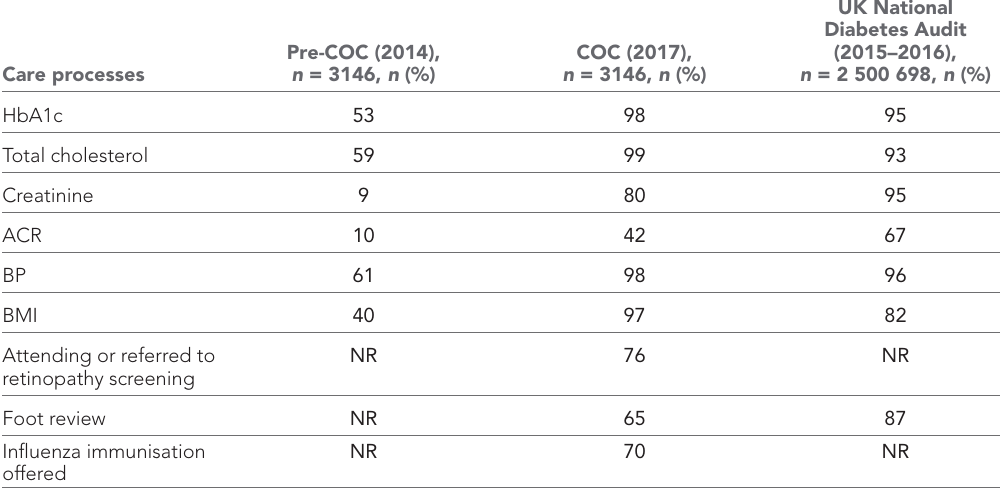
Table 1 Comparison of care processes over time (2014–2017) to UK National Diabetes Audit 2015–2016 Care processes